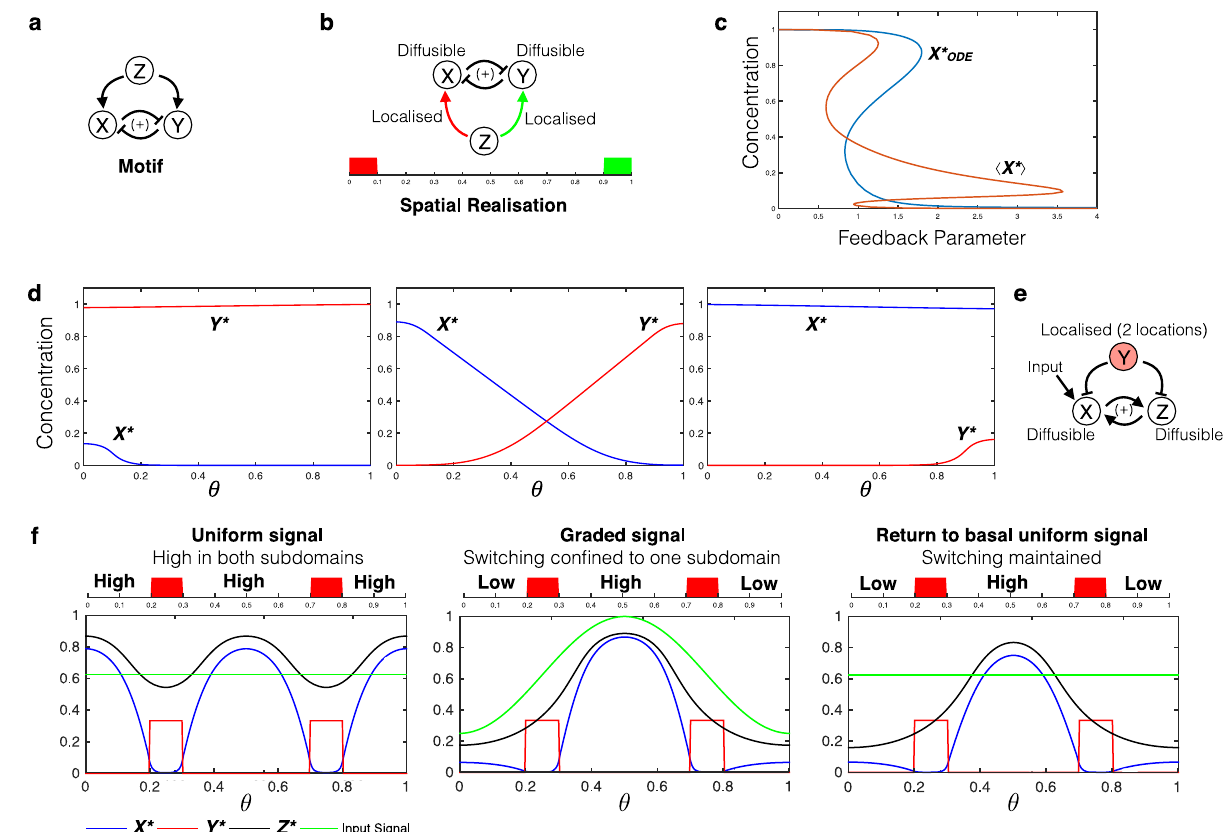
Fig. 3 Localisation can introduce new qualitative behaviour. a Bistable to tristable transition: motif under consideration, mutual inhibition between X and Y. b The spatially distributed realisation considered here involves the regulation of diffusible nodes X and Y by Z with the regulation localised at opposite ends of the domain. c Bifurcation diagram, with feedback strength of Y on X as bifurcation parameter. The corresponding ODE model exhibits bistability (blue curve) while tristability is seen in the distributed system (red curve depicting the spatial average). d The three stable, inhomogeneous steady state pro fi les are shown: in addition to two steady states where X or Y dominate, the system has a third steady state where they co-exist, each dominating in a particular region. Here blue and red curves denote X * and Y * respectively. e Spatial switching: motif under consideration, mutual activation (giving bistability) between X and Z (moderately diffusible); both inhibited by node Y, which is localised at two symmetric locations in a periodic domain. f Localised inhibition by Y divides the domain into two parts, and by trapping of fronts, and allows essentially different steady states of the X – Z bistable motif to be maintained in the two parts of the periodic domain (see left and right panels: both regions have high levels of X and Z (ON) in the left panel, while in the right panel, one region has low levels of X and Z (OFF)). Furthermore, the switching of steady states con fi ned to speci fi c sub-domains can be achieved by a graded input signal, and this switching remains when the gradation of signal is